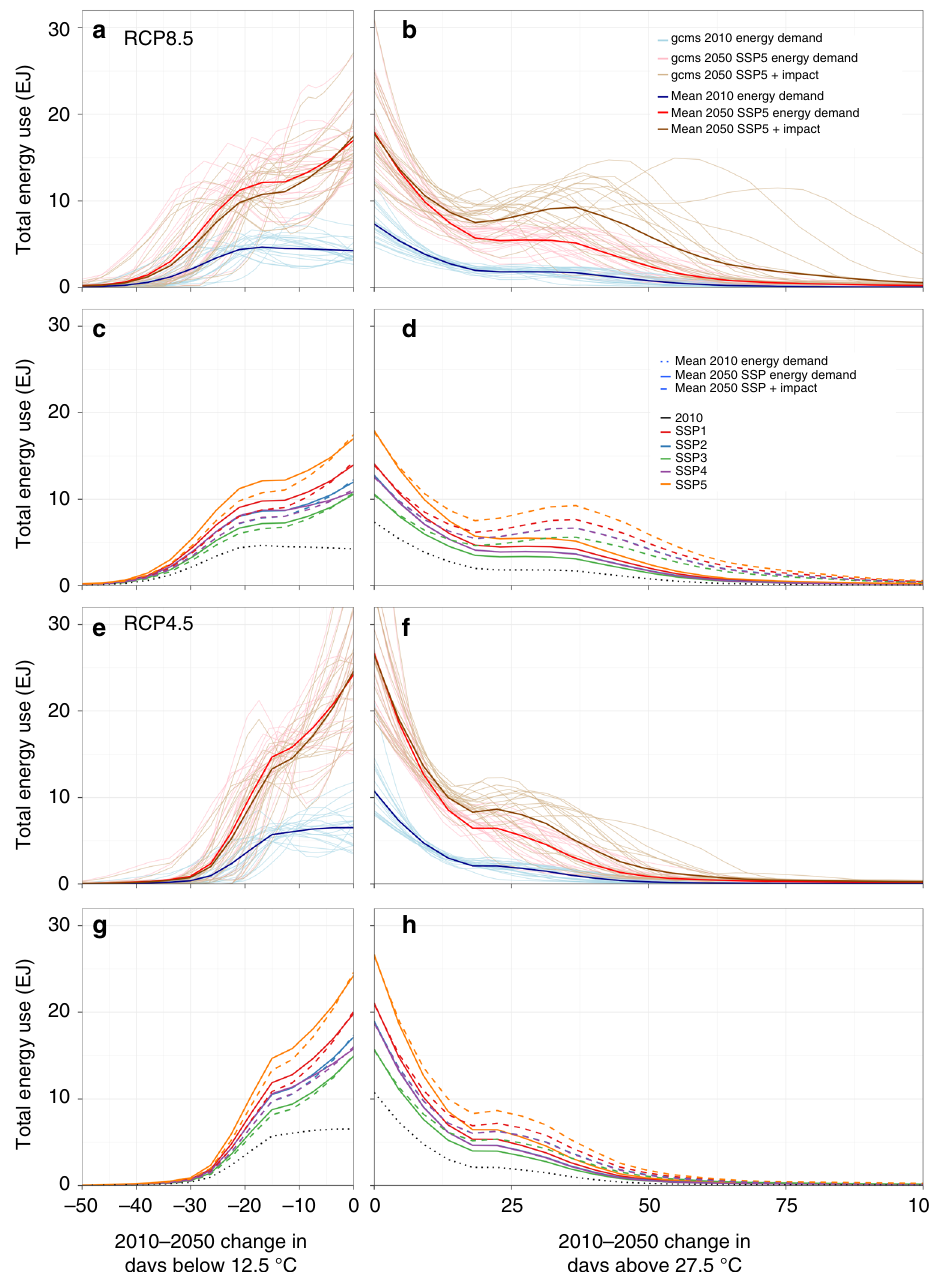
Fig. 2 The total energy demand exposed to changes in cold and hot days. The upper half displays the results for RCP 8.5, the bottom half for RCP 4.5. In the detailed panels ( a , b , e , f ) the blue lines depict present-day energy demand, and the red lines depict SSP5 baseline energy demand for 2050; brown lines indicate energy use under SSP5 after impacts of climate change (mean and all 21 individual ESMs) exposed to changes in hot and cold days. Aggregate panels ( c , d , g , h ) show the multi-ESM mean for all fi ve SSPs. Impacts from climate change are only shown for changes in hot ( b , d , f , h ) or cold ( a , c , e , g ) days; combined impacts are shown in Supplementary Fig.